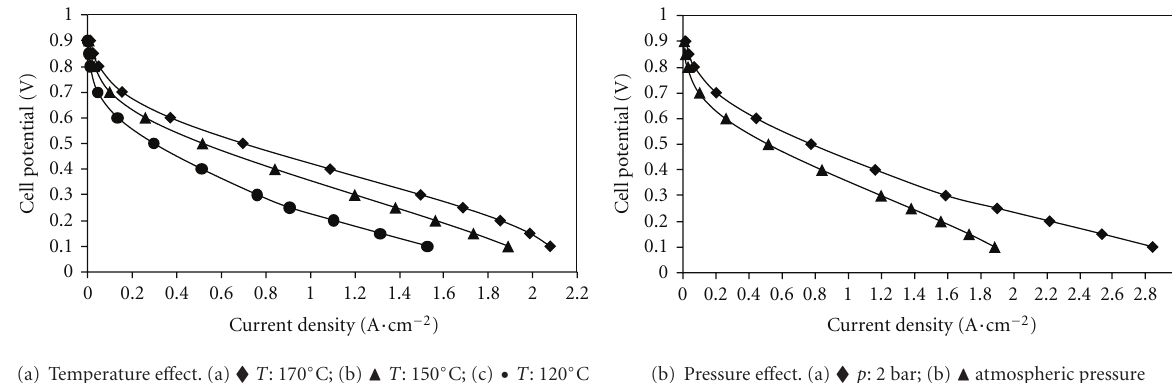
Figure 2: E ff ect of temperature and pressure on polarization curves for a PEM fuel cell. 50% Pt/C at the cathode and 20% Pt/C at the anode. Air was used at the cathode and hydrogen at the anode at atmospheric pressure.